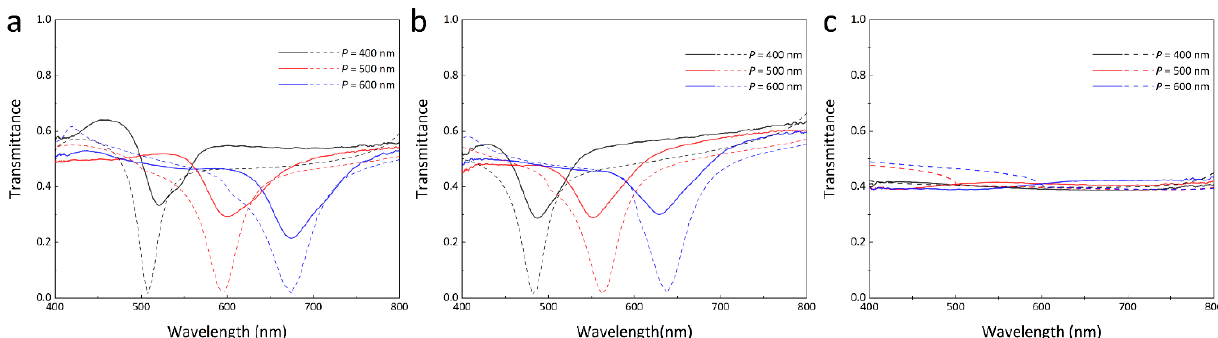
Figure 5. ( a ) The measured (solid line) and simulated (dash line) transmittance spectra with various periods ( P = 400 nm, P = 500 nm, and P = 600 nm) with SU8 as the waveguide layer for TE polarization. The thickness of SU8 t = 205 nm. ( b ) The measured (solid line) and simulated (dash line) transmittance spectra with various periods ( P = 400 nm, P = 500 nm and P = 600 nm) with SU8 as the waveguide layer for TE polarization. The thickness of SU8 t = 172 nm. ( c ) The measured (solid line) and simulated (dash line) transmittance with various periods ( P = 400 nm, P = 500 nm and P = 600 nm) with no SU8 for TE polarization. In all simulations, the duty cycle is set as 0.4. n s = 2.2 and n = 1.6. t is set as 200 nm and 170